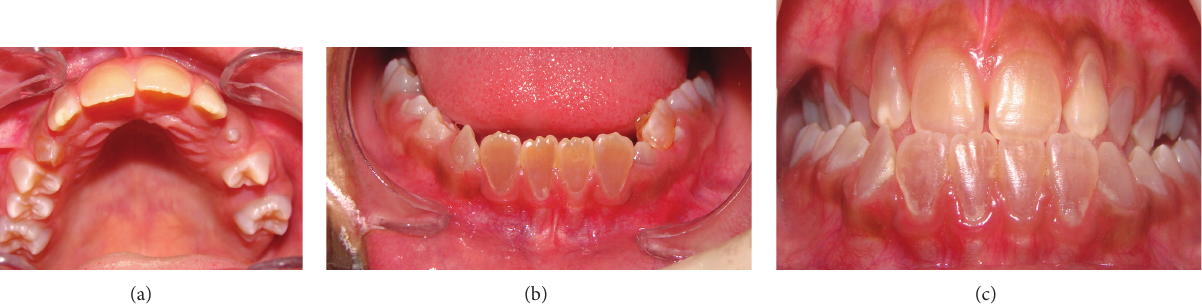
Figure 2: Anterior teeth showing brownish discoloring, a common clinical finding in type I dentinogenesis imperfecta. Upper dental arch